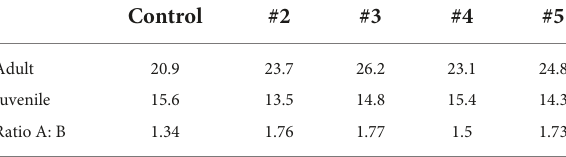
TABLE 4 Percentage of surviving strategies for 5 different drawings of 3,000 initial strategies from the pool of potential strategies, and the ratio of adult: juvenile